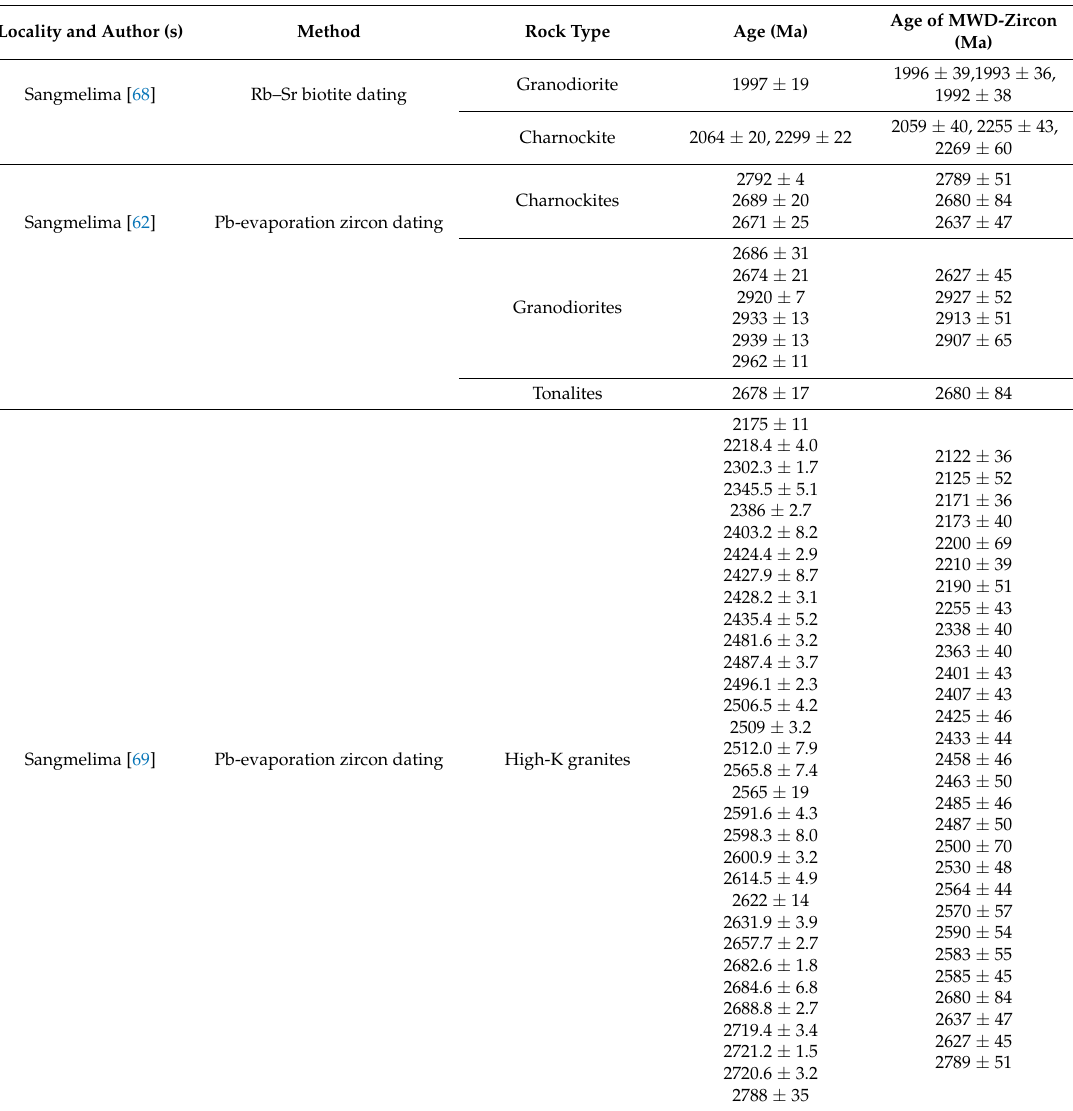
Table 5. Possible correlations between the ( 206 Pb/ 238 U) age of the western Meiganga detrital zircons and that of zircons from some rocks within regional geological